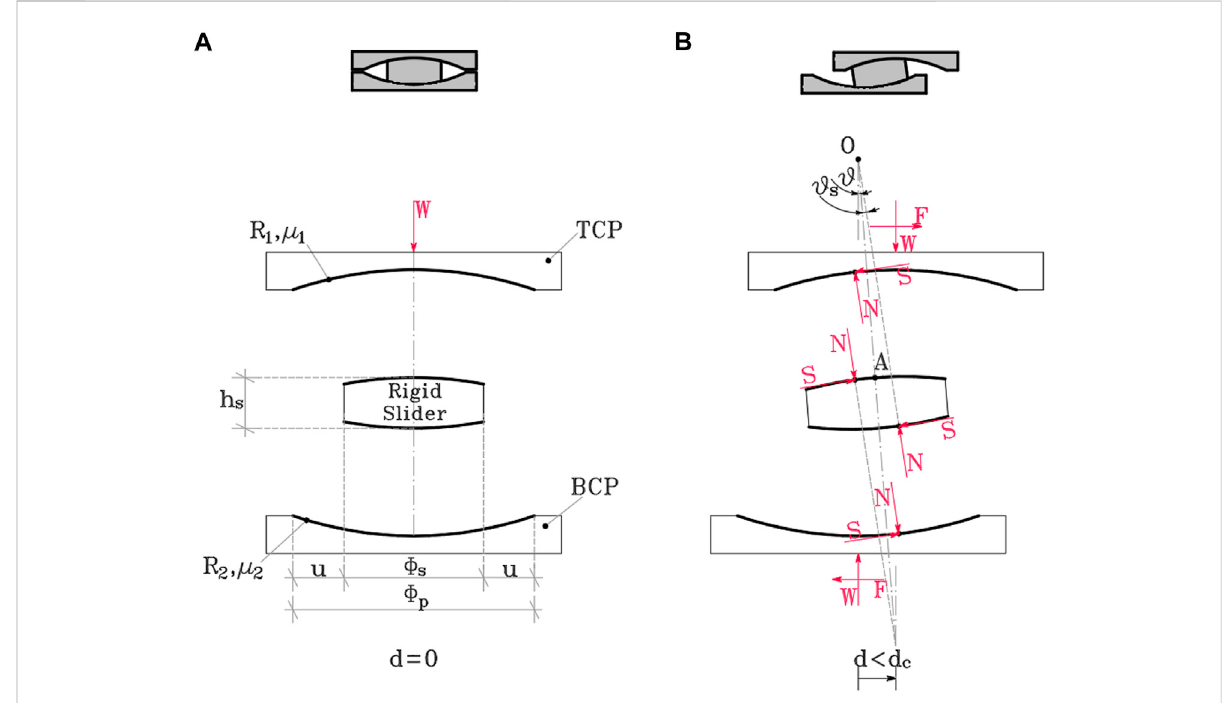
FIGURE 1 Exploded cross-section of the DCCSS bearing. in static conditions (A) and in the sliding regime (B) (Sarlis and Constantinou